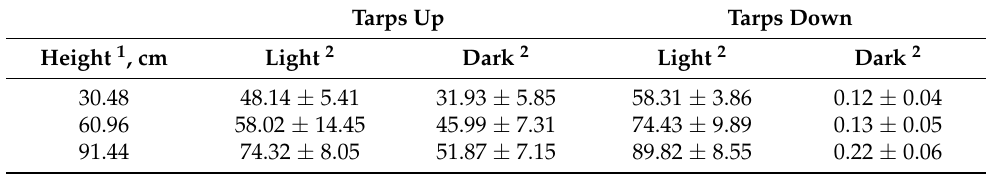
Table 1. Illuminance in farrowing crates with and without light deprivation tarps.